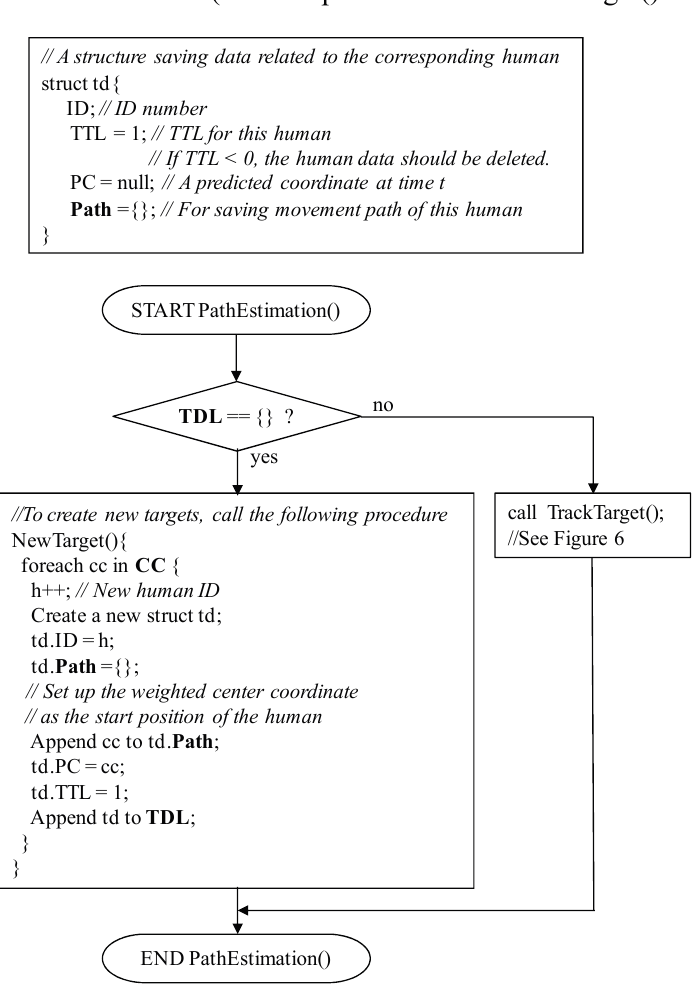
Figure 5. Procedure of the path estimation